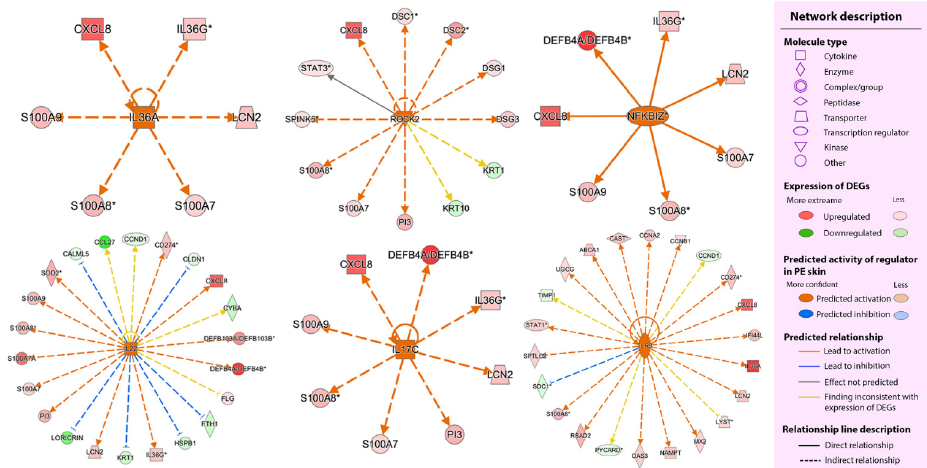
Figure 5. Potential regulators and their relationship to the target dataset’s DEGs. In each radiant, the molecule at the center is the predicted potential regulator and the outer circular molecules are the dataset’s DEGs. DEGs, differentially expressed genes; PE skin, peripheral edge of the lesional skin.